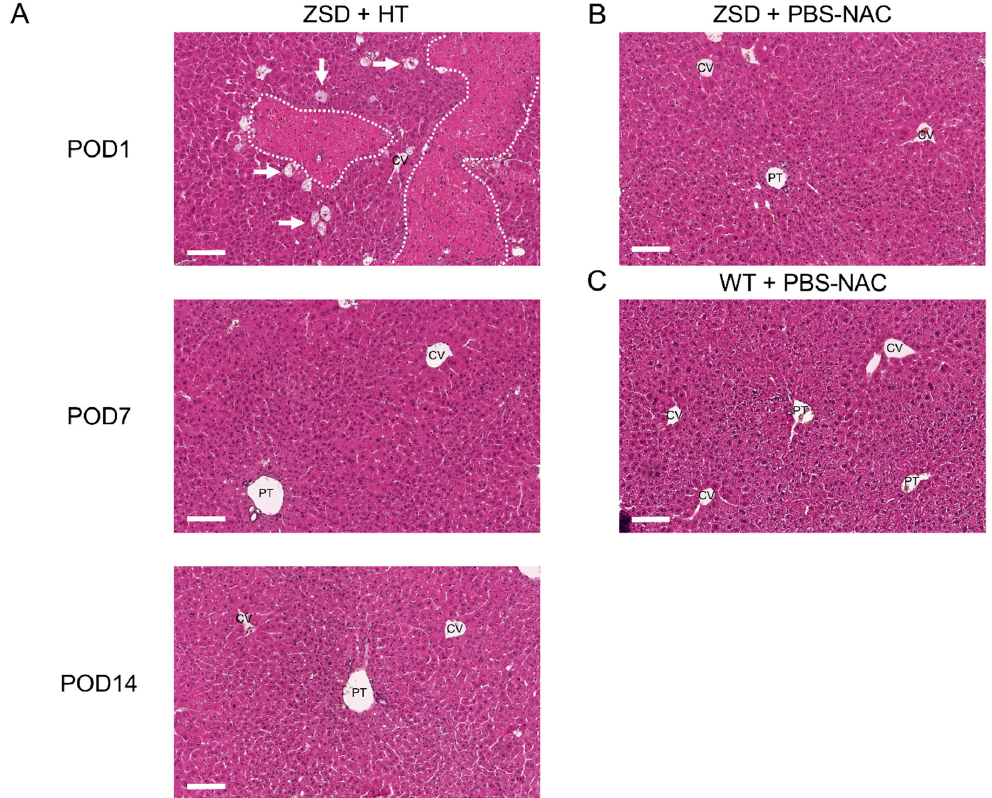
Figure 4. Liver histological analysis in Zellweger spectrum disorder (ZSD) mice confirmed ZSD liver disease hallmarks and uncovered spontaneously resolving focal liver necrosis following hepatocyte transplantation (HT). ( A ) Post-operative day (POD) 1 mice liver exhibited necrosis areas with inflammatory cells infiltrate (dotted lines) sparing the central vein (CV), along with ballooning degeneration of hepatocytes (arrows). POD7 and POD14 and ( B ) control (PBS-NAC) ZSD livers showed canalicular proliferation in portal tracts (PT) and progressive hepatocyte hypertrophy from PT to CV, as previously reported [18]. Necrosis was not detected at POD7 and POD14, nor in ZSD control livers, nor in ( C ) wild-type (WT) control livers. PBS-NAC: N -acetylcysteine in phosphate buffered saline. Scale bar: 100 µ